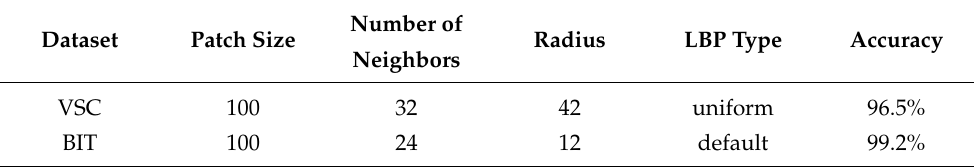
Table 4. Best configuration parameters and accuracy of recognition test in VSC and BIT datasets.